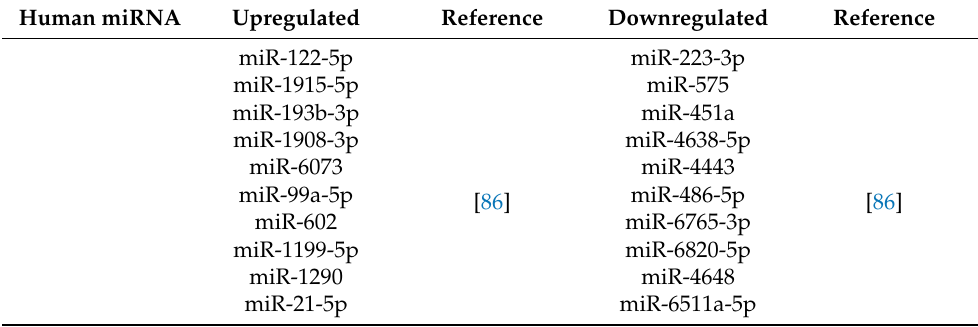
Table 1. Expression of miRNAs in AIH in human and animal